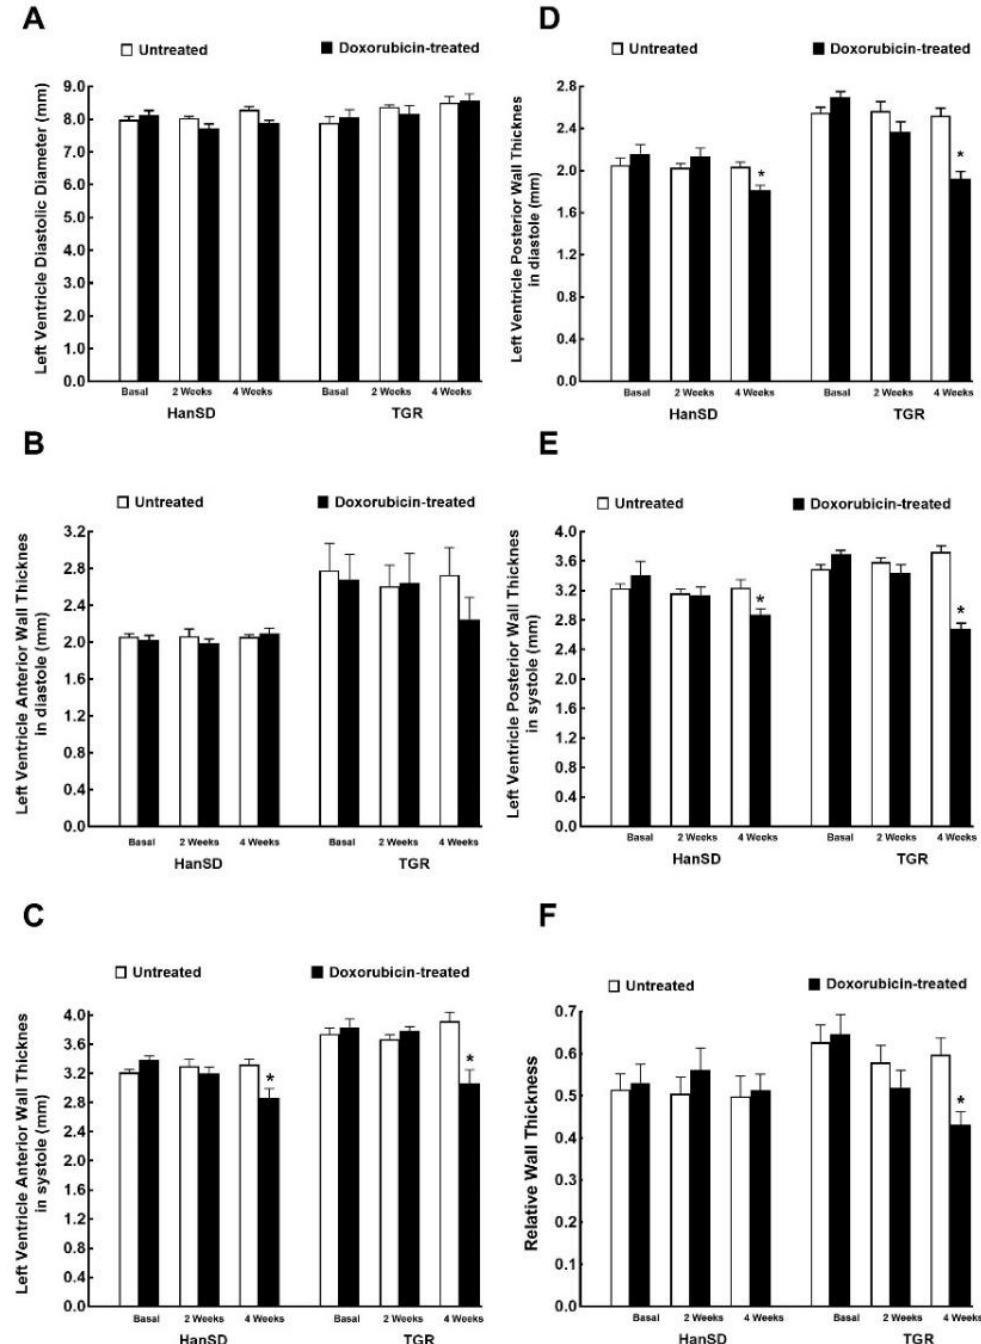
Figure 2. Assessment of the cardiac morphological parameters by echocardiography before administration of doxorubicin (basal values), at the end of doxorubicin administration (2 weeks values) and two weeks after termination of doxorubicin treatment (4 weeks values) in normotensive, transgene-negative Hannover Sprague-Dawley (HanSD) and hypertensive, Ren-2 transgenic (TGR) rats. Left ventricle diastolic diameter ( A ), left ventricle anterior wall thickness in diastole ( B ), left ventricle anterior wall thickness in systole ( C ), left ventricle posterior wall thickness in diastole ( D ), left ventricle anterior wall thickness in ( E ), relative wall thickness ( F ). * p < 0.05 compared with untreated animals of the same strain at the same time point. The values are means ±